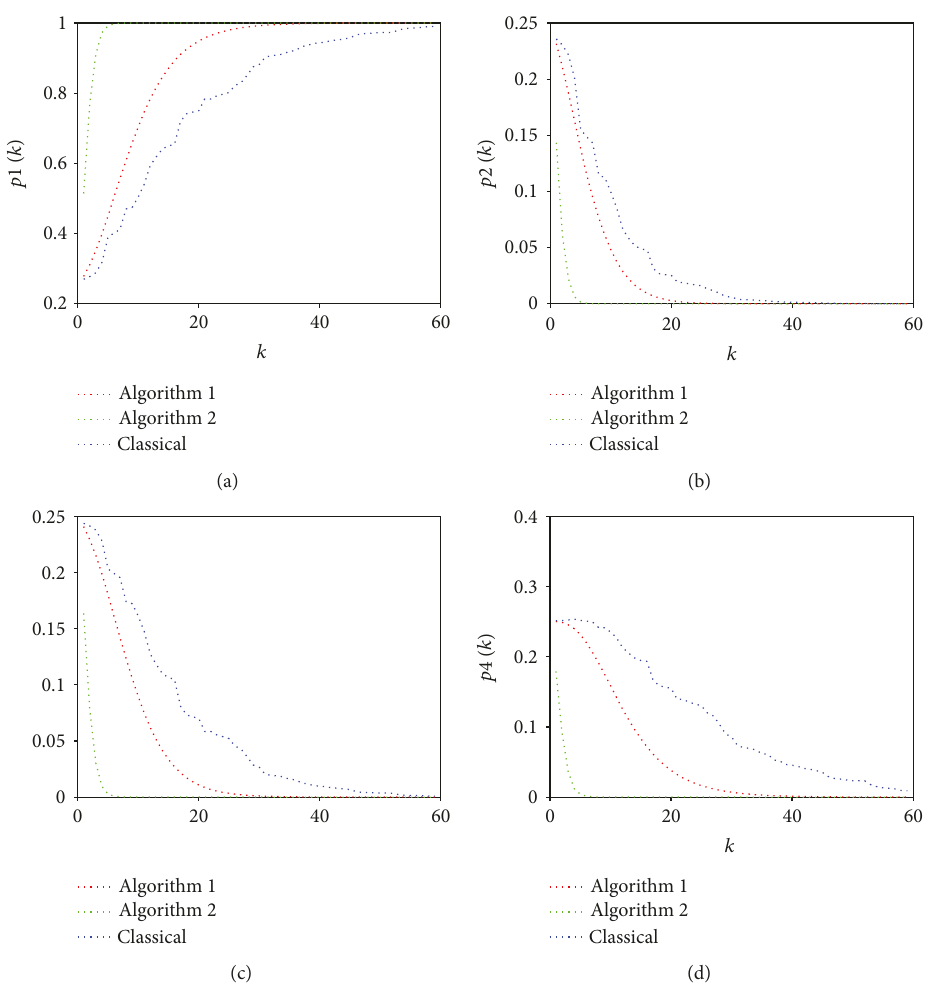
Figure 4: The weight signals of three weighting algorithms in Case